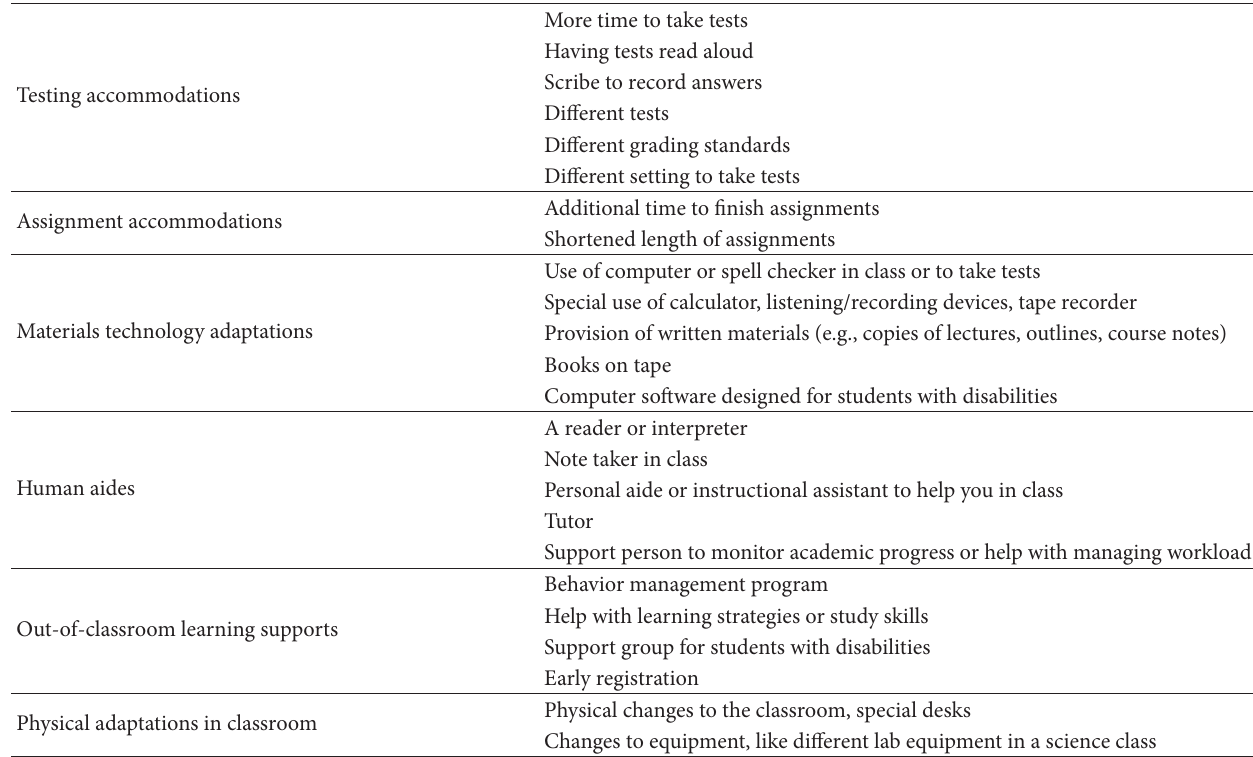
Table 3: Examples of services, accommodations, or other help received during postsecondary education by primary categories and